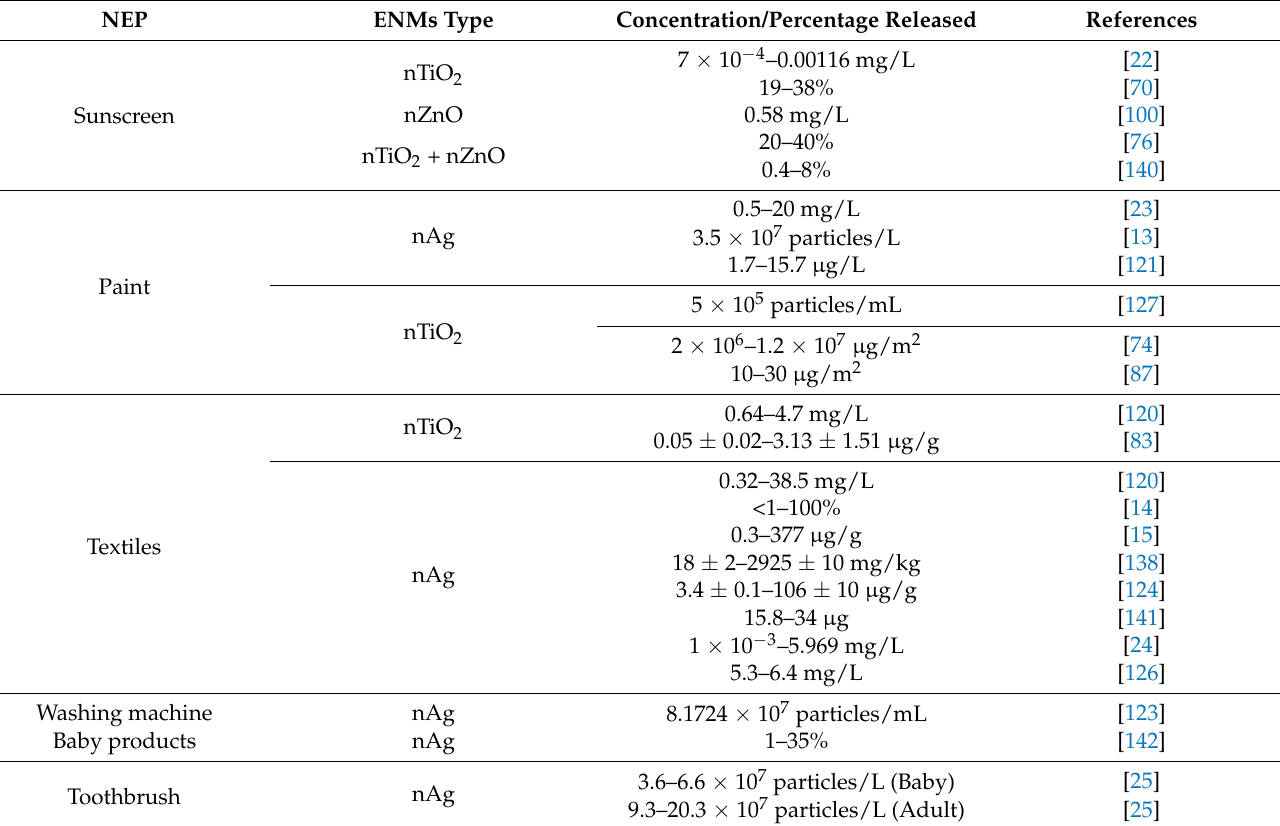
Table 2. The total concentrations released from different nano-enabled products (NEPs). ENMs = engineered nanomaterials. NEP ENMs Type Concentration/Percentage